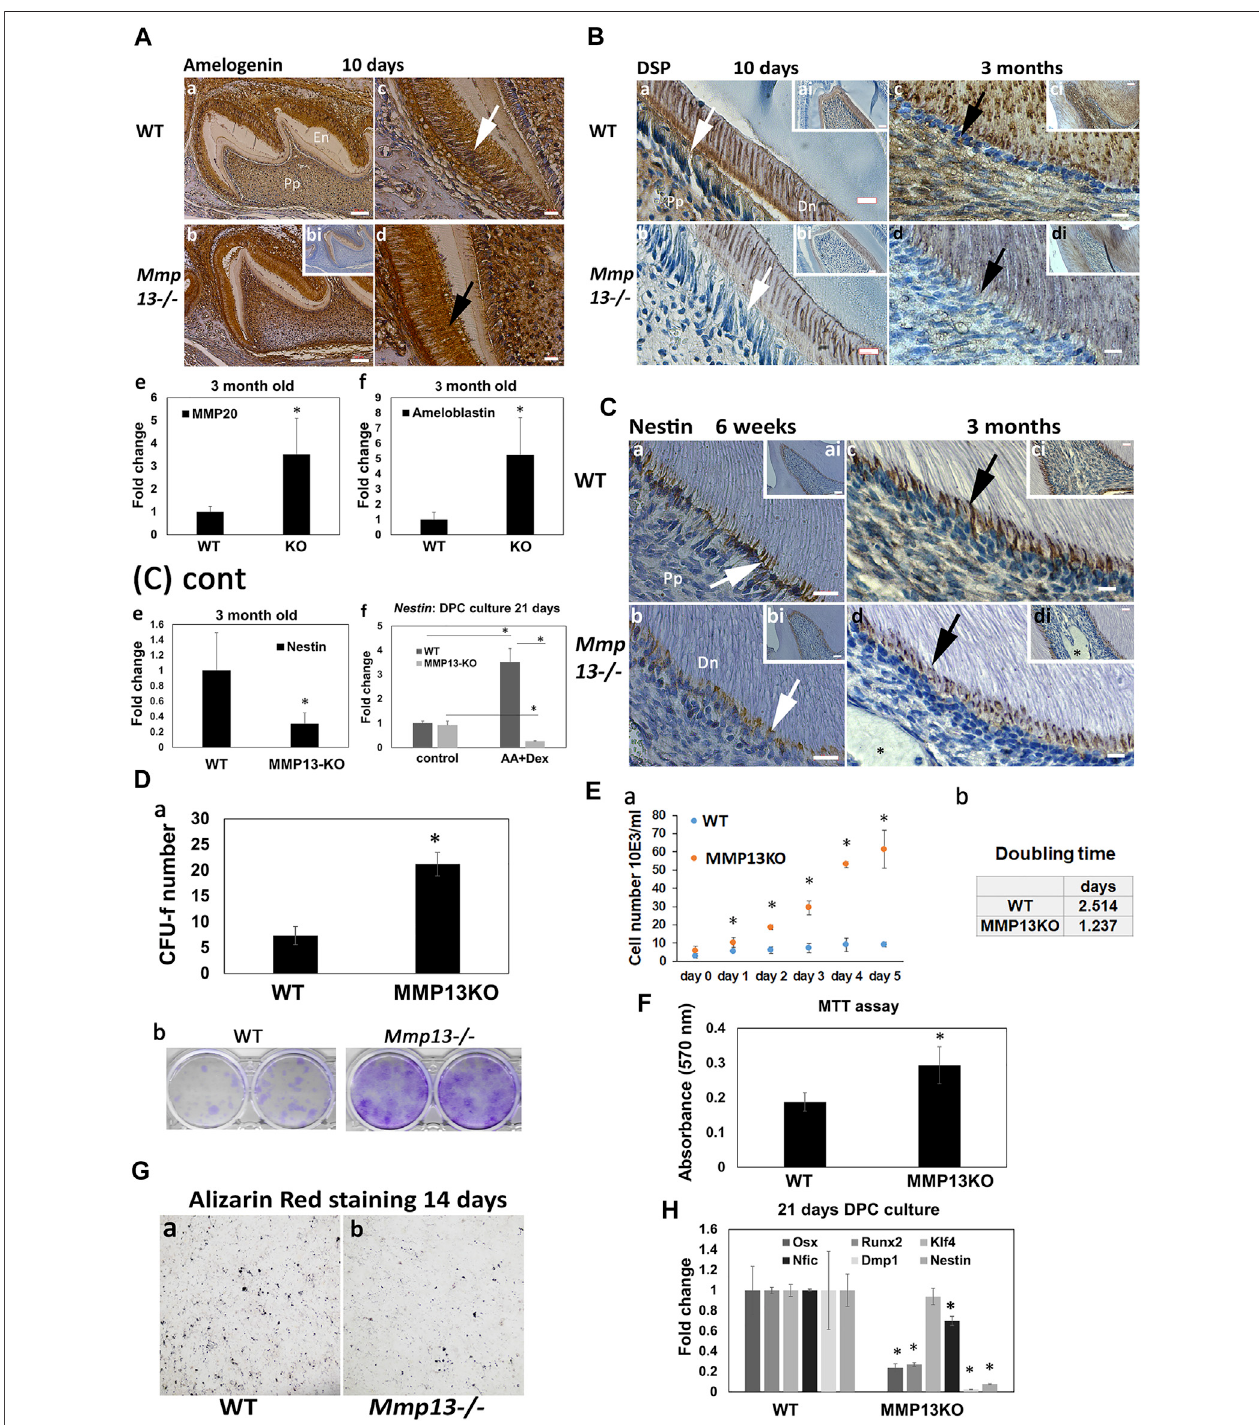
FIGURE 4 | Odontoblast marker expression is reduced after MMP13-loss, as DPC proliferation increases. (A) Amelogenin-expression is higher in the ameloblast layer ( c , white arrow; d , black arrow) of Mmp13 − / − molars thanin WT and unstained control (bi) at postnatal 10-day. Enamel volume is also visibly reduced in Mmp13 − / − compared with WT (a, b) . Scale bars = (c, b) 100 μ m (original mag. ×10); (c, d) 10 μ m (original mag. ×40). (e, f) Mmp20 and ameloblastin gene expression signi fi cantly upregulatedintissue fromincisorsofMMP13KO at3-month. (B) DSPreducedinexpression inodontoblast ( a – d ,whiteandblack arrows)anddentin in Mmp13 − / − sections at 10-day and 3-month (a – d) . (a – d) represent higher magni fi cations of the cusp area in inset ai – di. Scale bars = (a, b) 7 μ m (original mag. ×40); (ai – di) 16 μ m (original mag. ×20); (c, d) 5 μ m (original mag. ×63). (C) Nestin-expression reduced in Mmp13 − / − sections (b, d) in the odontoblast cell and process ( a – d , - white, black